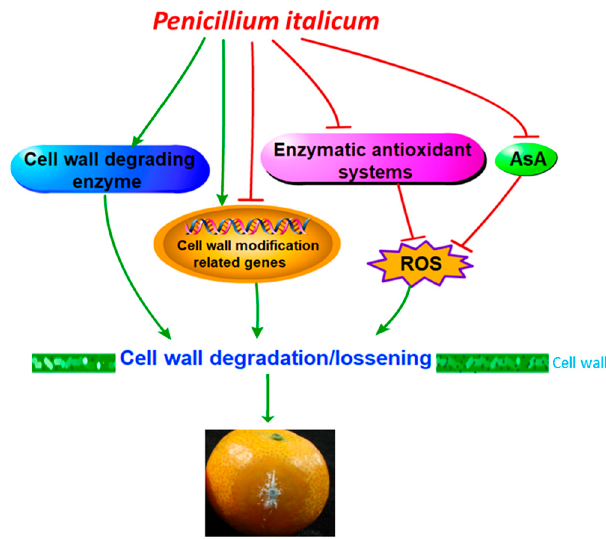
Figure 6. The possible mechanism of P. italicum infection inducing cell wall degradation of harvested ‘shatangju’ mandarin fruit. → Represents positive effects while Represents negative effects. AsA: ascorbic acid; ROS: reactive oxygen species.